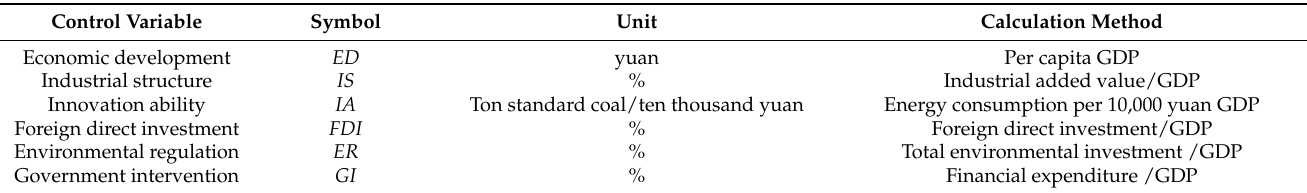
Table 5. Selection of indicators for green development efficiency impact factors.